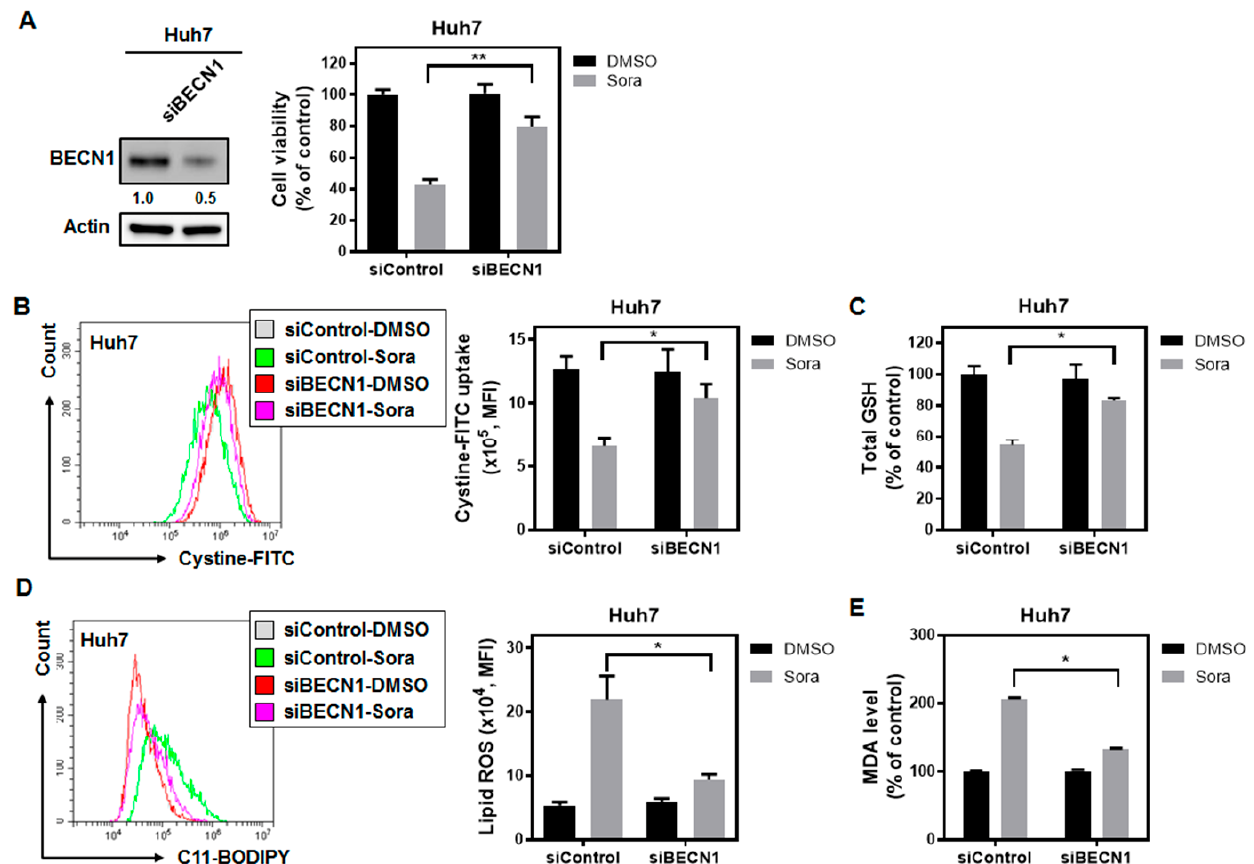
Figure 6. BECN1 silencing relieves sorafenib-triggered ferroptosis in HCC cells: ( A ) Silencing of BECN1 by siRNA in Huh7 cells alleviated sorafenib-induced ferroptotic cell death, ( B ) restored system Xc − ’s transporter activity, ( C ) replenished intracellular total GSH, ( D ) reduced lipid ROS levels, and ( E ) restrained lipid peroxidation. Columns: mean; bars: SD (n ≥ 3). Statistical significance was evaluated using the Mann–Whitney U test (*, p < 0.05; **, p < 0.01).